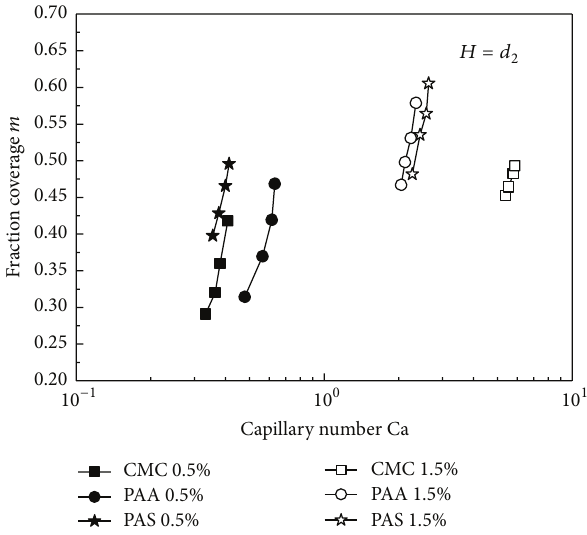
Figure 12: Increase of fractional coverage 𝑚/𝑚 𝑁 as a function of Weissenberg number Wi when sudden contraction tube angle is 𝜃 = 45 ∘ , 𝑄 = 600 mL/min and 𝐻 = 𝑑 1 .